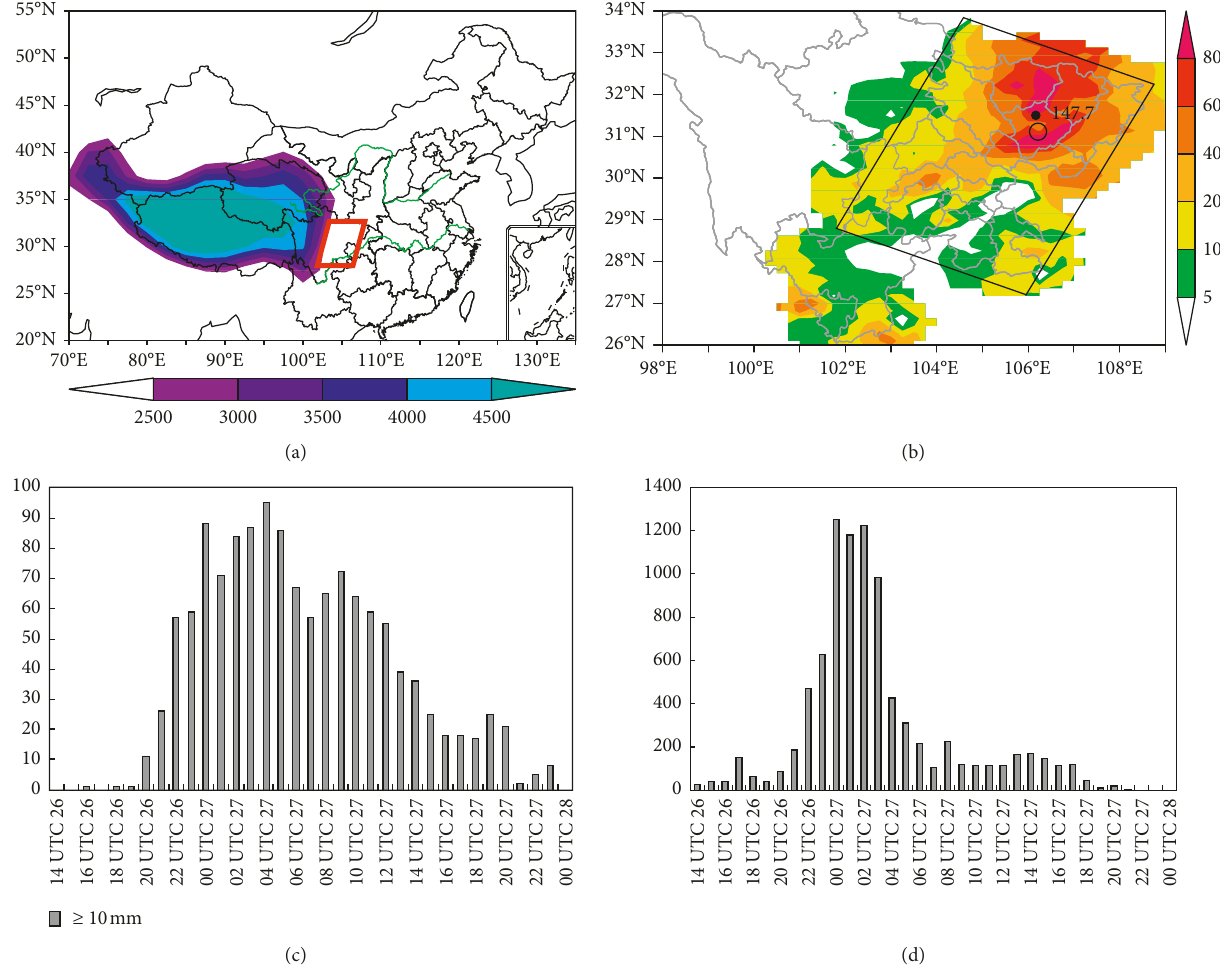
Figure 1: The location of Sichuan Basin (a) (the shaded area is terrain of Tibetan plateau (unit: m)), the accumulated precipitation (b) (in mm) from 1200 UTC 26 to 0000 UTC 28 October 2014, the number of stations with hourly precipitation lightning times (d). “ • ” is the location of precipitation center (Yilong); “